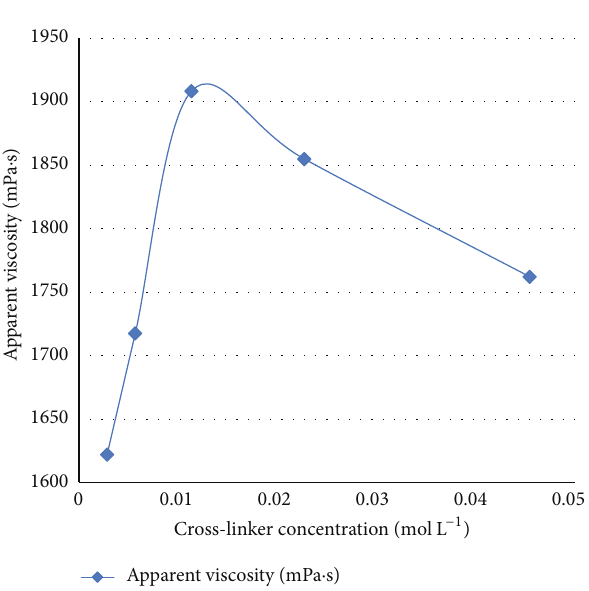
Figure 9: Effect of cross-linker concentration on apparent